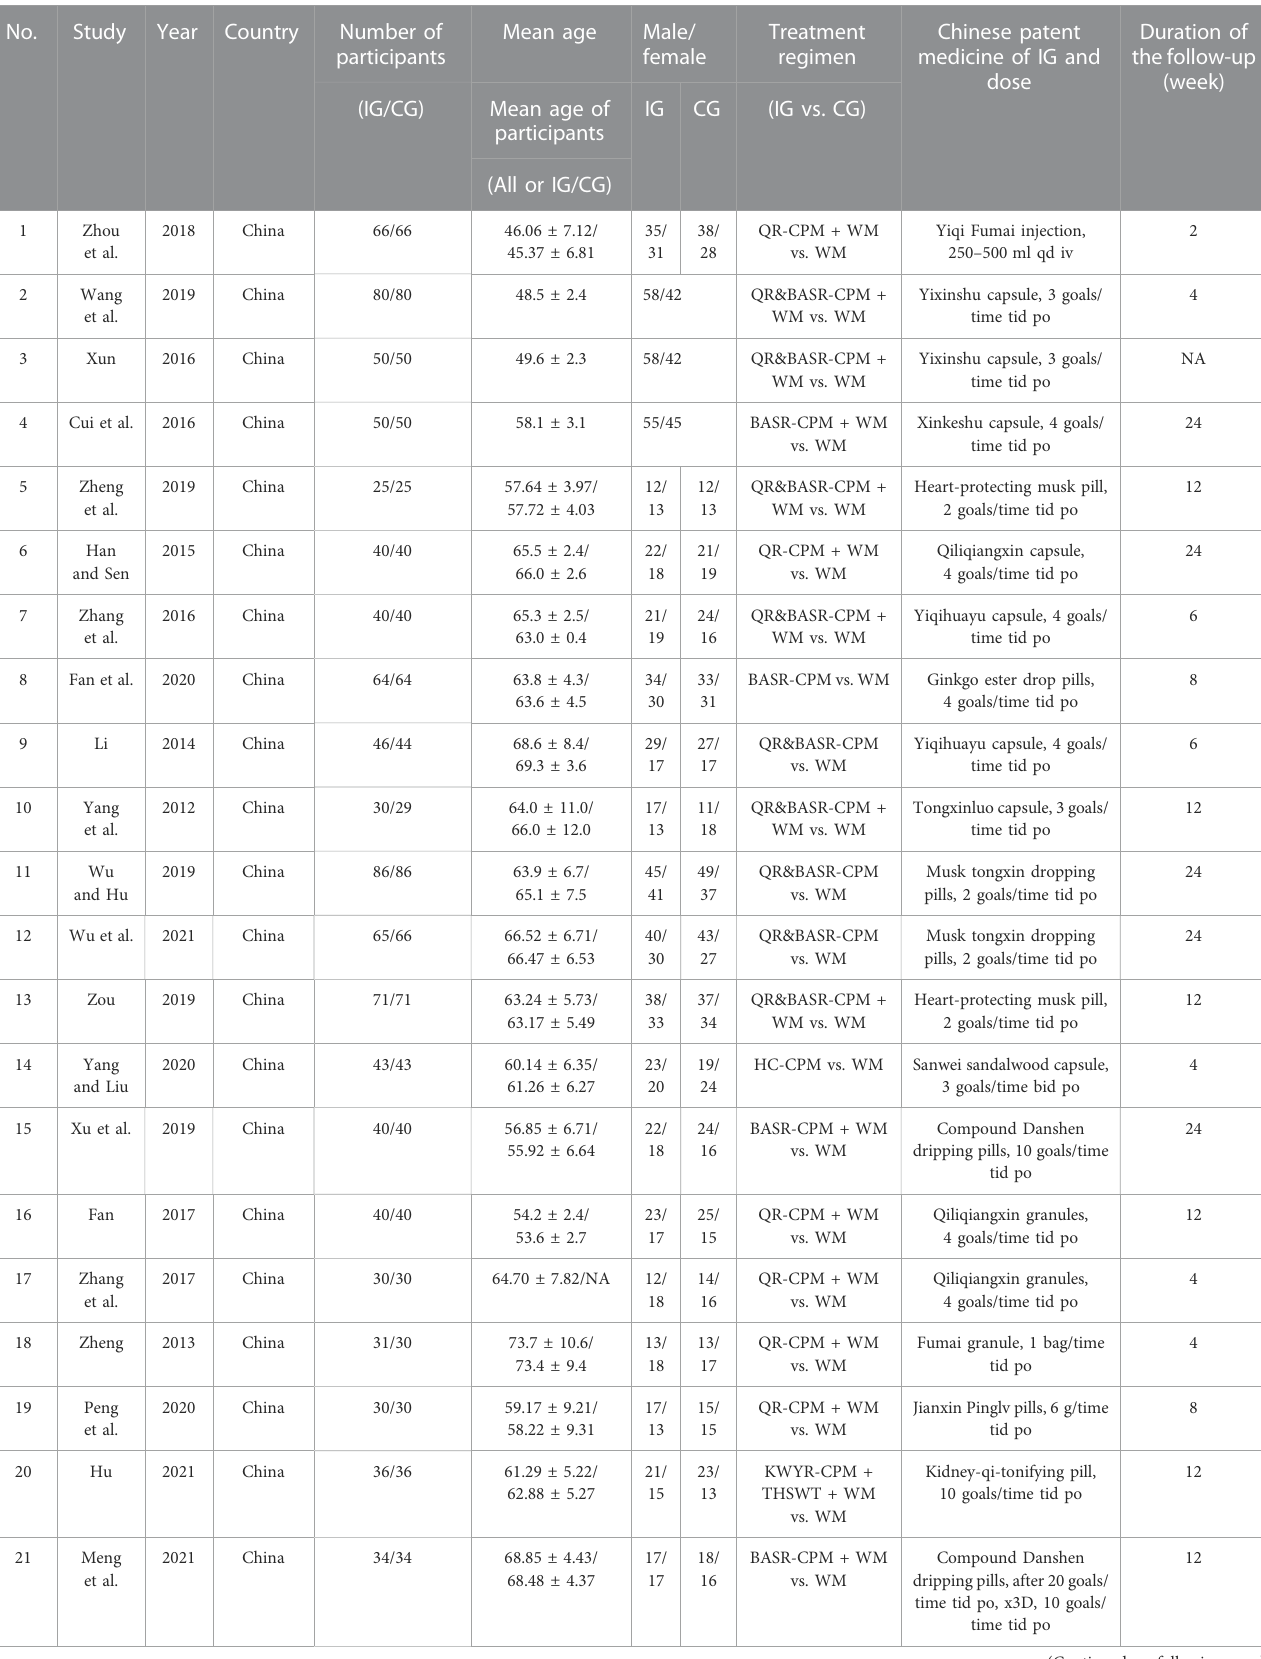
TABLE 1 Characteristics of each RCTs in included studies.